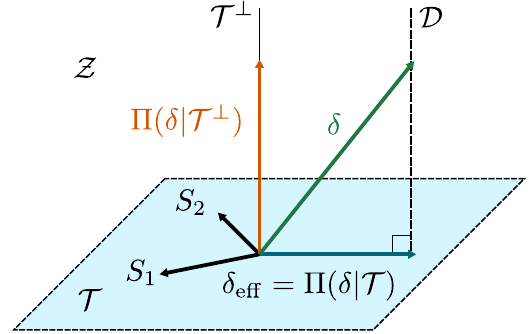
FIG. 1. The whole space in the picture represents Z , the space of zero-mean operators. T is the tangent space spanned by the tangent set f S g . T ⊥ is the orthocomplement, which contains elements orthogonal to all the scores. D is the set of influence operators, which all have a fixed projection in T determined by ∂ β . δ is an influence operator in D . The projection of δ into T gives the efficient influence δ , which has the smallest norm eff among all the influence operators. Π ð δ j T ⊥ Þ is the projection of δ into T ⊥